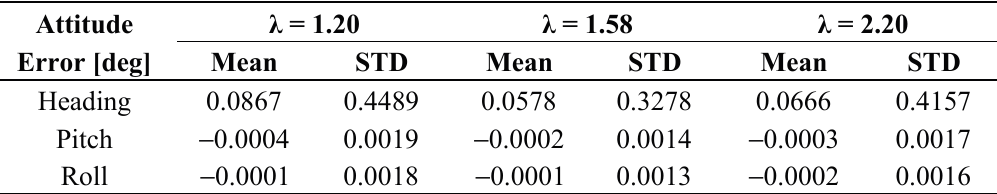
Table 13. Statistics for Algorithm